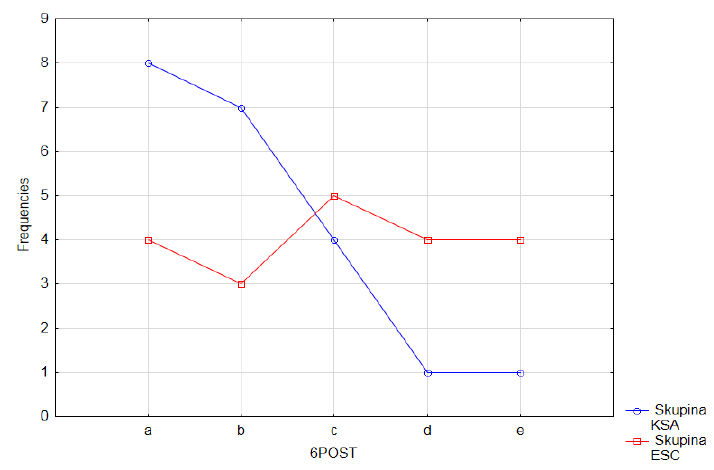
Figure 17. Interaction graph of the eighth item of the pretest - 8PRE.